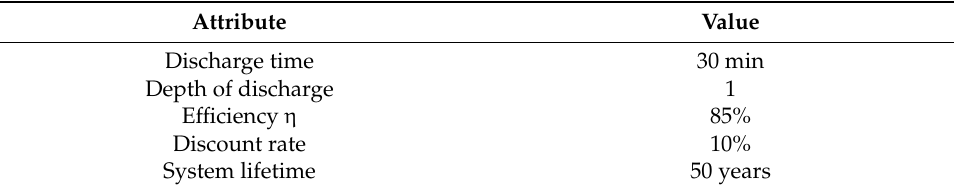
Table 10. Attribute examples of the gravity energy storage system.